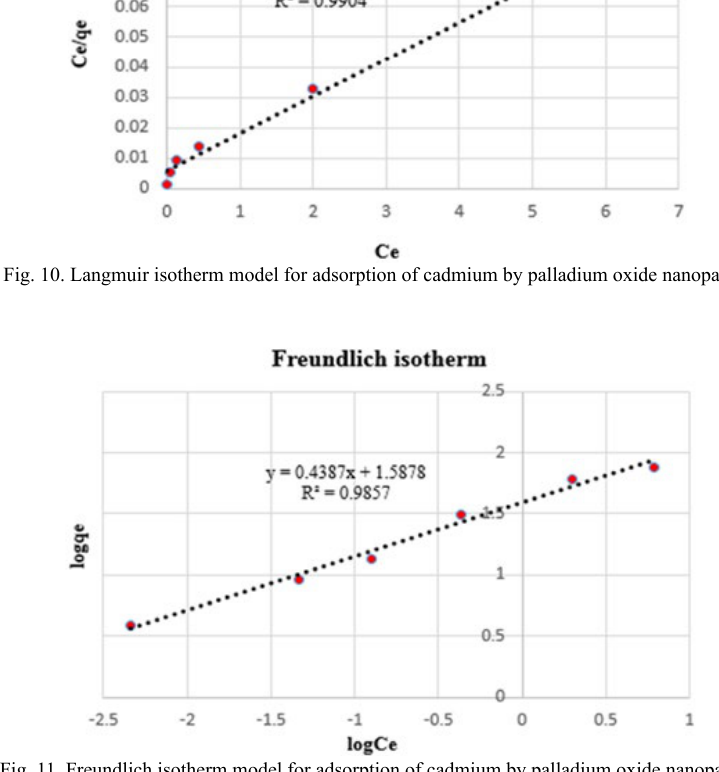
Fig. 11. Freundlich isotherm model for adsorption of cadmium by palladium oxide nanoparticles